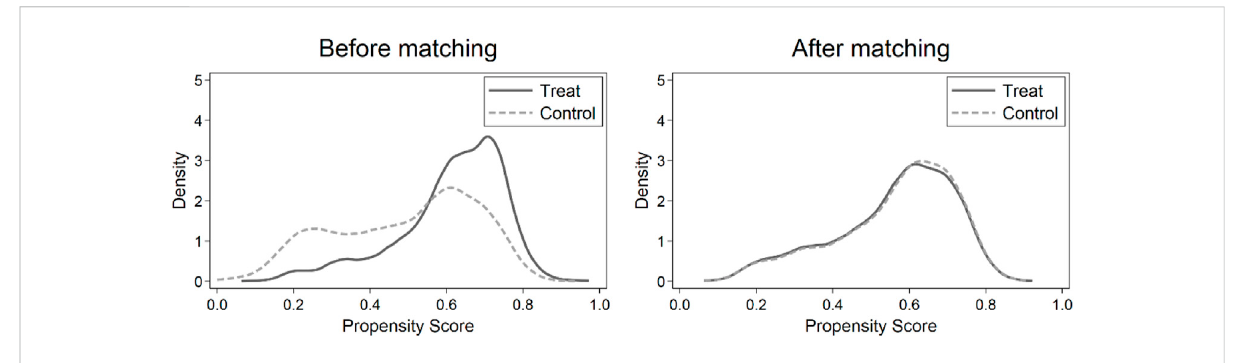
FIGURE 3 Kernel density function plot before and after